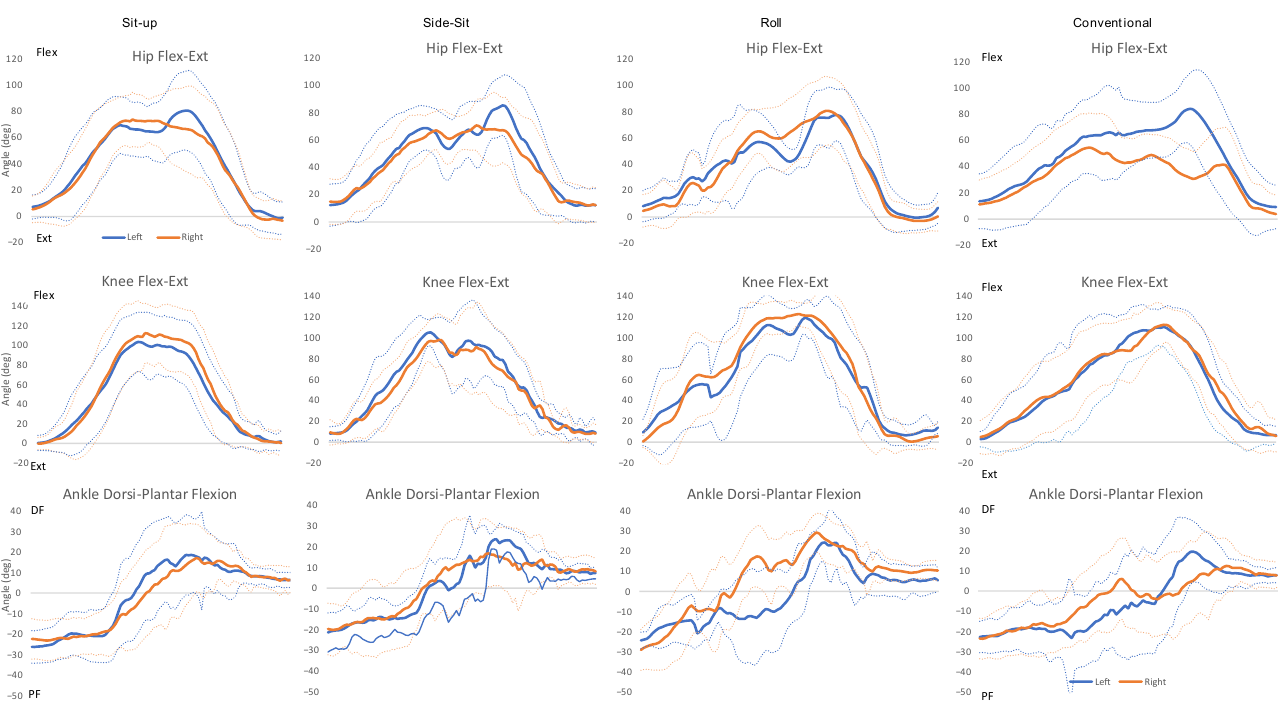
Figure 1. Kinematics graphs representing the average (solid lines) and standard deviation (dashed lines) of the sagittal plane for the hip, knee and ankle joints during the rise − from − floor tasks starting at supine, ending with standing. Data along the X axis plot the trajectory of the movement task, time-normalized to 101 data points, with 0 signifying the initiation of the task and 101 the completion.